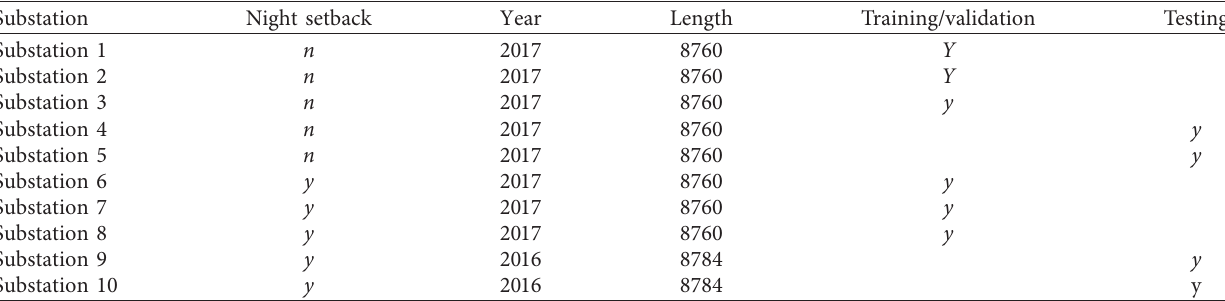
Table 1: Overview of the original